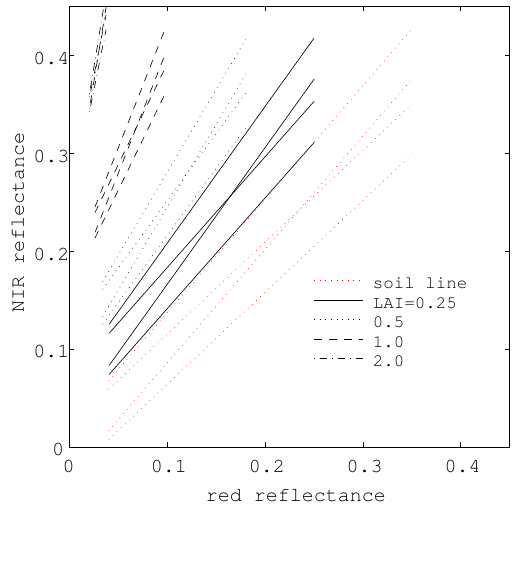
Figure 3. Vegetation isolines at various LAIs with four extrem soil